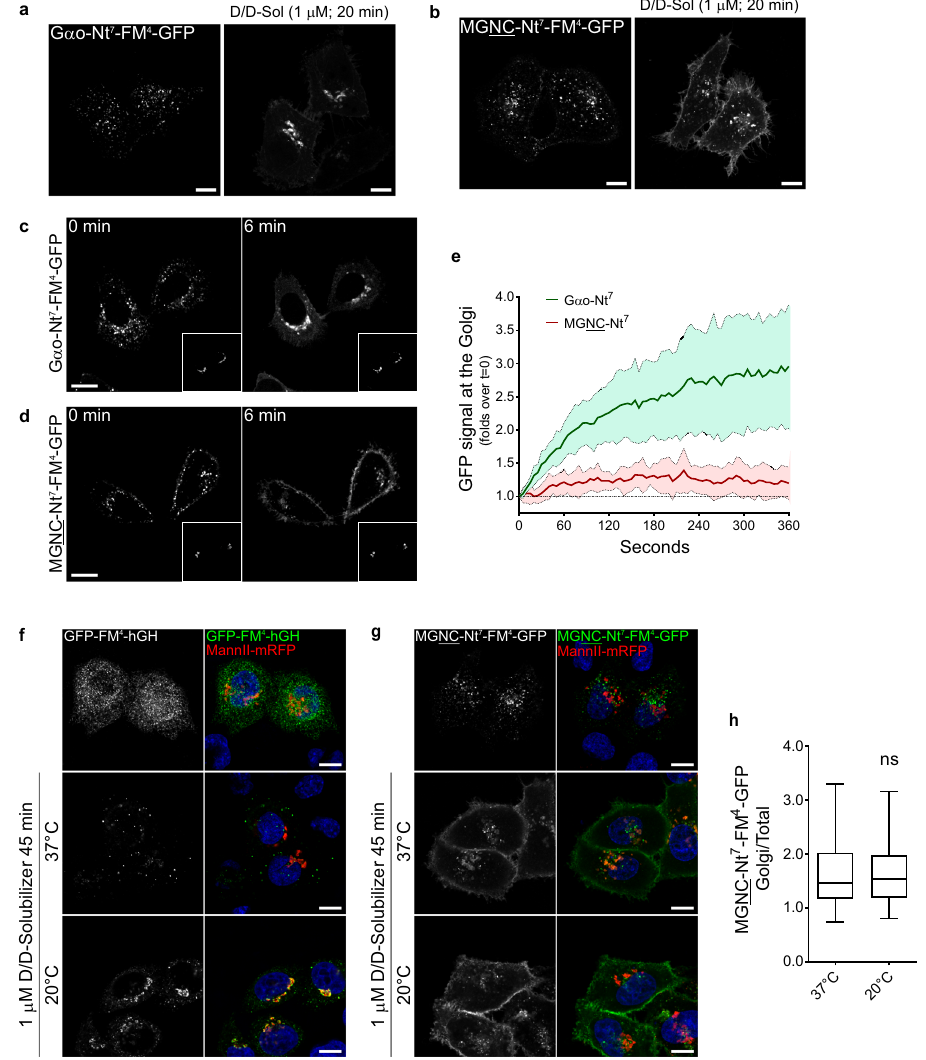
Fig. 3 Targeting of Nt 7 -GFP. a , b Reverse dimerization (RD) assay in HeLa expressing G α o-Nt 7 -FM 4 -GFP ( a ) or MGNC-Nt 7 -FM 4 -GFP ( b ). Cytosolic clusters formed by the Nt 7 -FM 4 -GFP constructs dissolve by the addition of D/D solubilizer (D/D-Sol) and show their expected localizations. Underlined letters indicate residues substituted in G α o-Nt 7 . c – e Live imaging of HeLa cells co-expressing G α o-Nt 7 -FM 4 -GFP ( c ) or MGNC-Nt 7 -FM 4 -GFP ( d ) and the Golgi marker MannII-mRFP (bottom right insets). Representative images of the Nt 7 -FM 4 -GFP constructs at the time of D/D solubilizer addition (0 min) and after 6 min ( c , d ). Increase upon time of Nt 7 -FM 4 -GFP constructs at the Golgi region ( e ). Note that G α o-Nt 7 -FM 4 -GFP quickly targets the Golgi region, while MGNC-Nt 7 -FM 4 -GFP only slightly accumulates at the Golgi. Data represent mean ± s.d. (G α o-Nt 7 , n = 12; MGNC-Nt 7 , n = 11). f – h RD assay in HeLa cells expressing the secretable control GFP-FM 4 -hGH ( f ) or MGNC-Nt 7 -FM 4 -GFP ( g ) performed at 37 °C or at 20 °C to inhibit Golgi transport. Incubation with D/D solubilizer results in the almost complete secretion of GFP-FM 4 -hGH at 37 °C but in Golgi retention at 20 °C ( f ). PM targeting of MGNC-Nt 7 - FM 4 -GFP seems not affected by the 20 °C temperature block and its presence at the Golgi region (MannII-mRFP) is not higher than at 37 °C ( g ). Mean fl uorescence intensity of MGNC-Nt 7 -FM 4 -GFP, Golgi over total cell ( h ). Box plots indicate median (middle line), 25th, 75th percentile (box), and lowest, highest value (whiskers); three independent experiments (37 °C, n = 49; 20 °C, n = 40). a – d , f , g Scale bars, 10 µ m. P value was determined using a two- sided unpaired t -test for ( h ). ns: not signi fi cant. Source data are provided as a Source Data fi le.